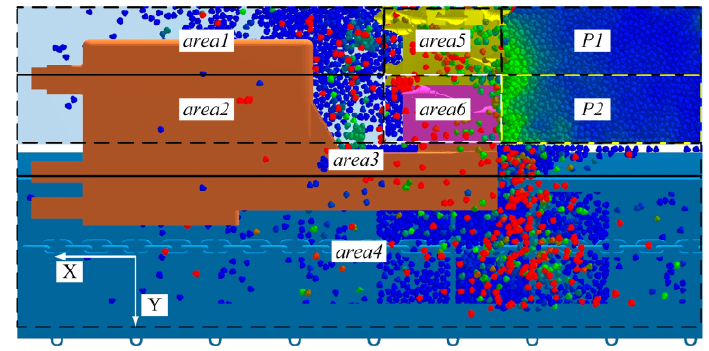
Figure 10. The diagram of the different statistical